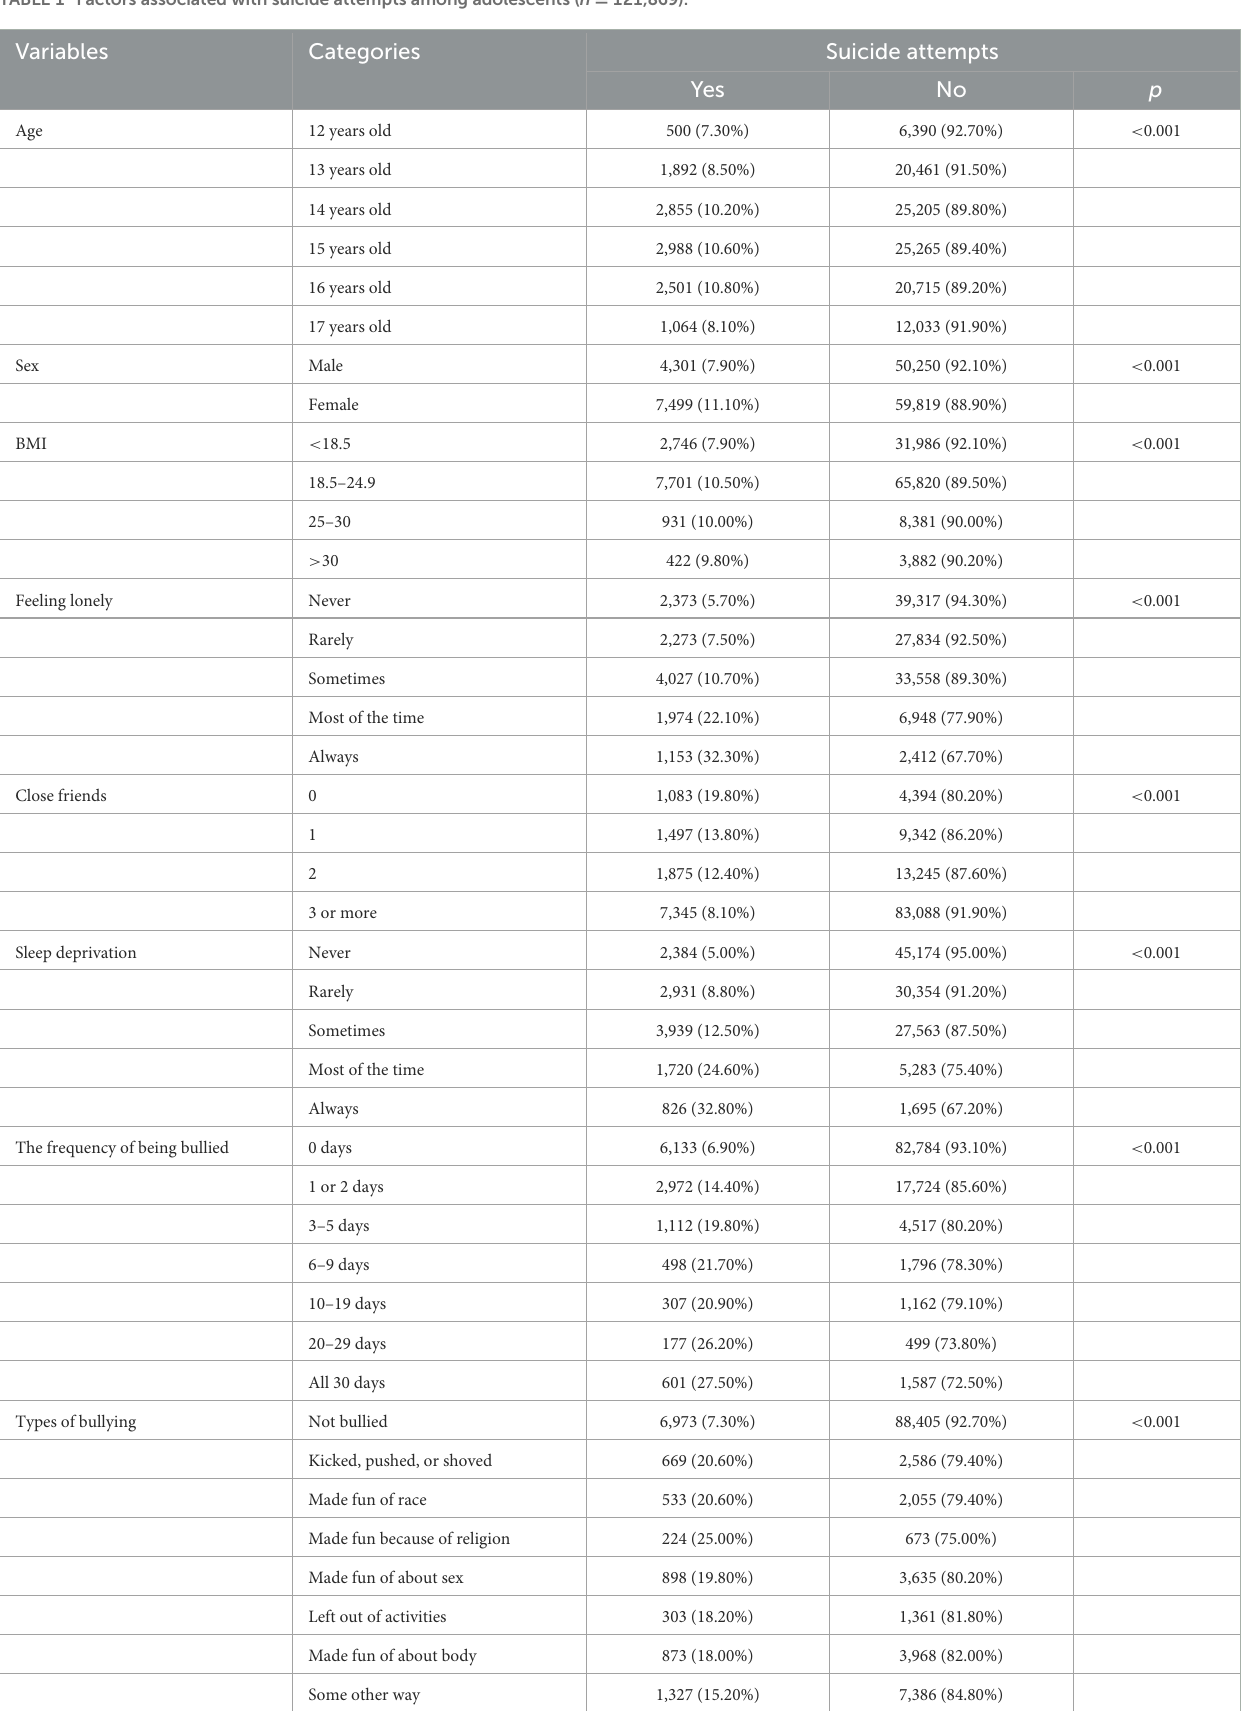
TABLE 1 Factors associated with suicide attempts among adolescents ( n =